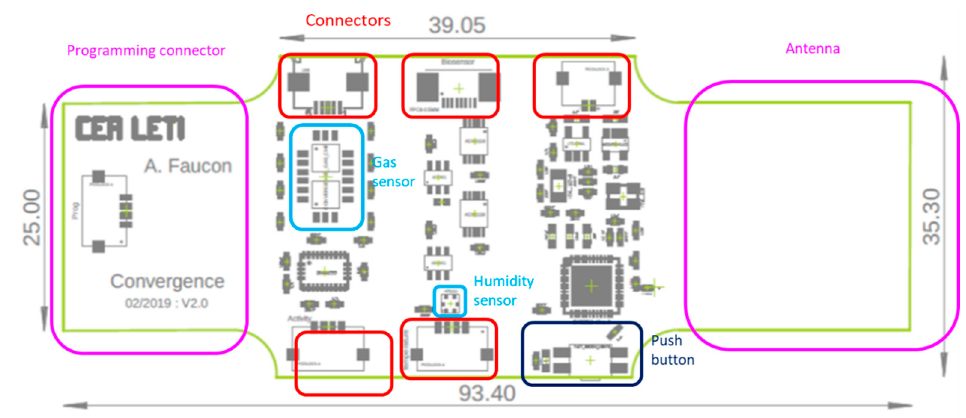
Figure 6. Flex PCB: design and dimensions.